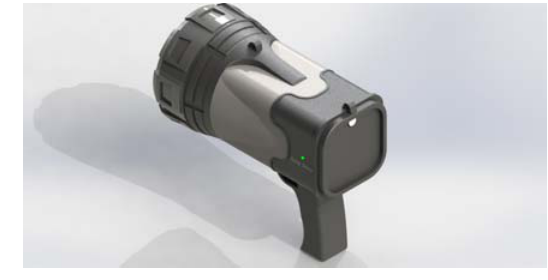
Figure 18 – Е lectronic stethoscope BDS-VX Рис . 18 – Электронный стетоскоп BDS-VX Слика 18 – Електронски стетоскоп